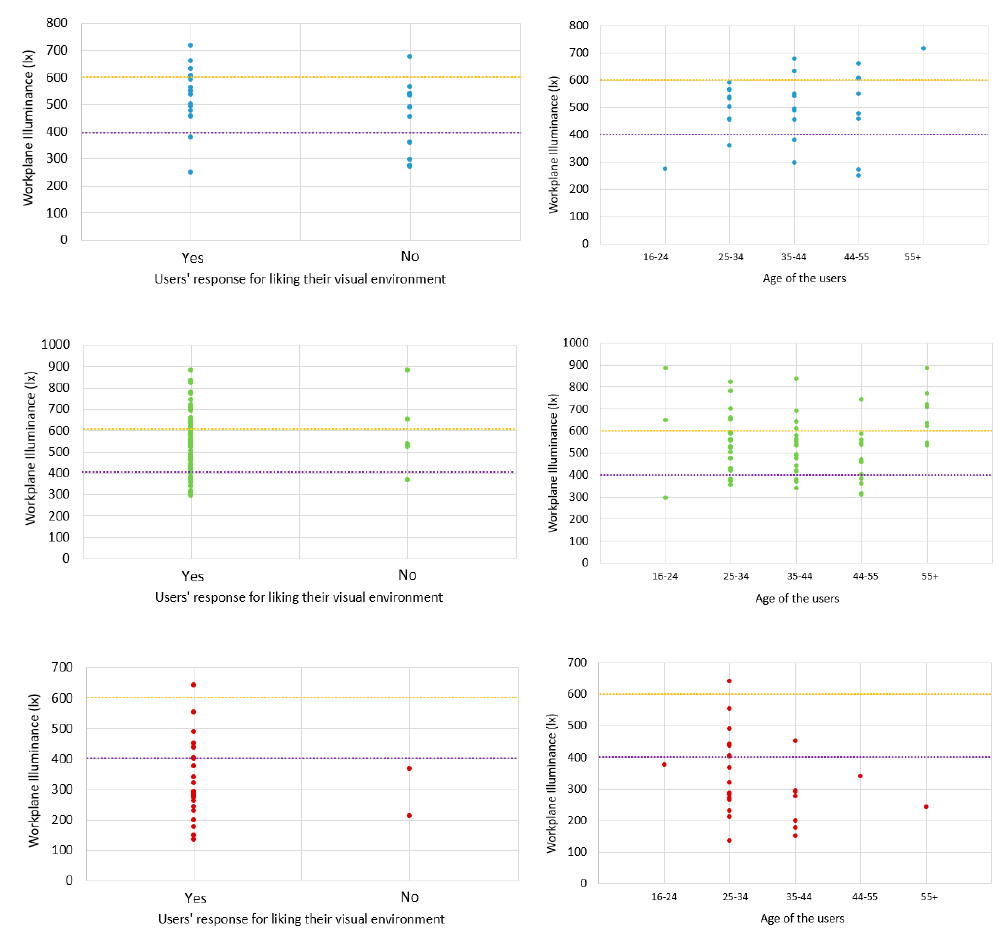
Figure 19. Illuminance measurements vs. the occupants’ response concerning liking their visual environment ( left ) and their age ( right ).